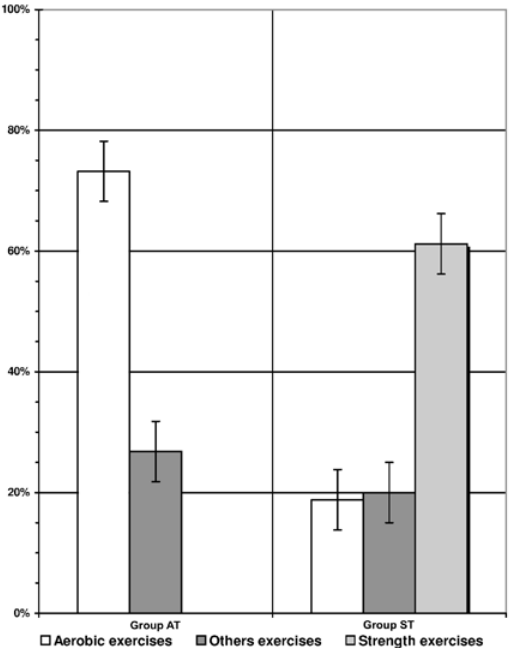
Figure 1: The parts (in percent) of whole time of training sessions mainly aerobic, strength type and other exercises in groups of over- weight females with aerobic (AT) and strength (ST)